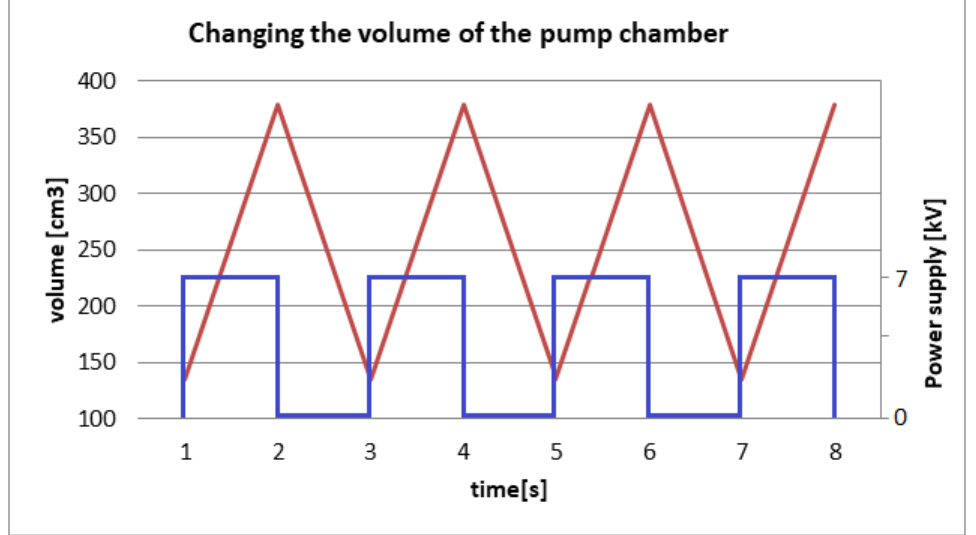
Figure 12. Supply voltage waveform and volume change of one pump chamber.